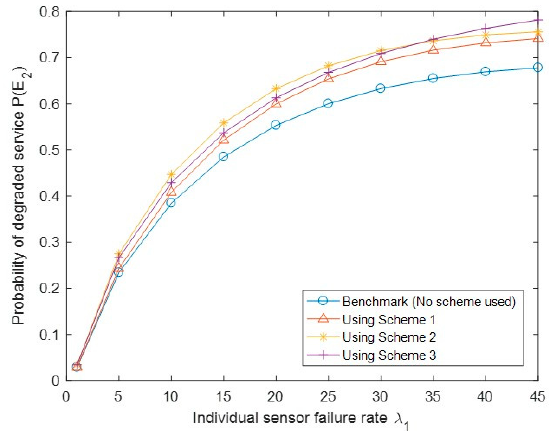
Figure 12. Performance comparison of the probability of degraded service P ( E 2 ) under the benchmark and three API schemes.